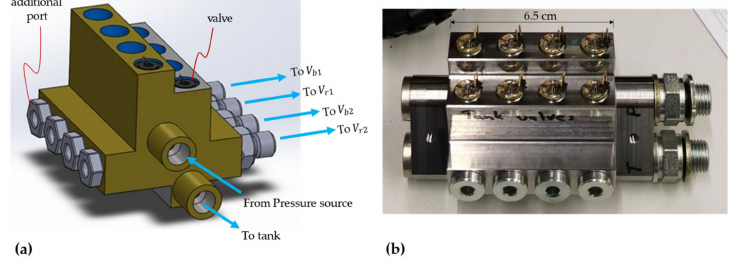
Figure 22. Valve manifold housing eight 2/2-way valves: ( a ) CAD; ( b ) procured valve